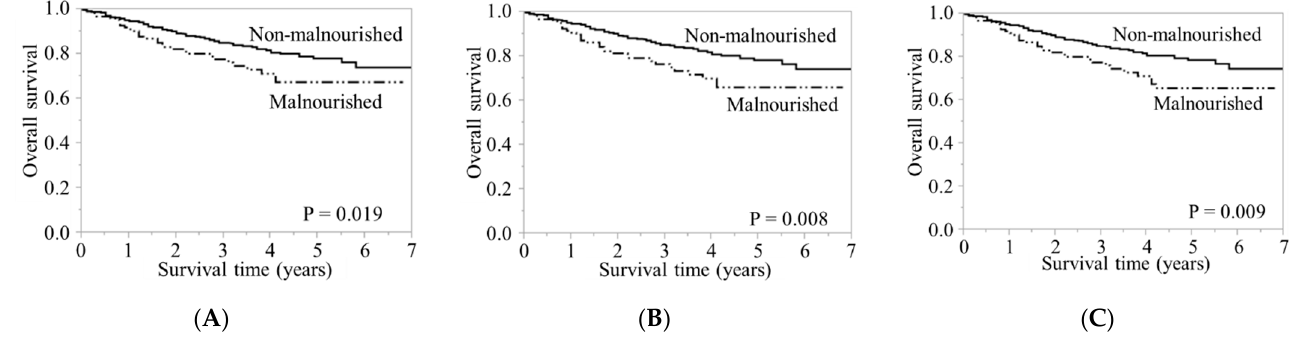
Figure 2. Kaplan–Meier survival curves by GLIM criteria malnutrition. ( A ) GLIM using SMI; ( B ) GLIM using FFMI; ( C ) GLIM using AC in all patients. GLIM, Global Leadership Initiative on Malnutrition; SMI, skeletal muscle mass index; FFMI, fat-free mass index; AC, arm circumference.